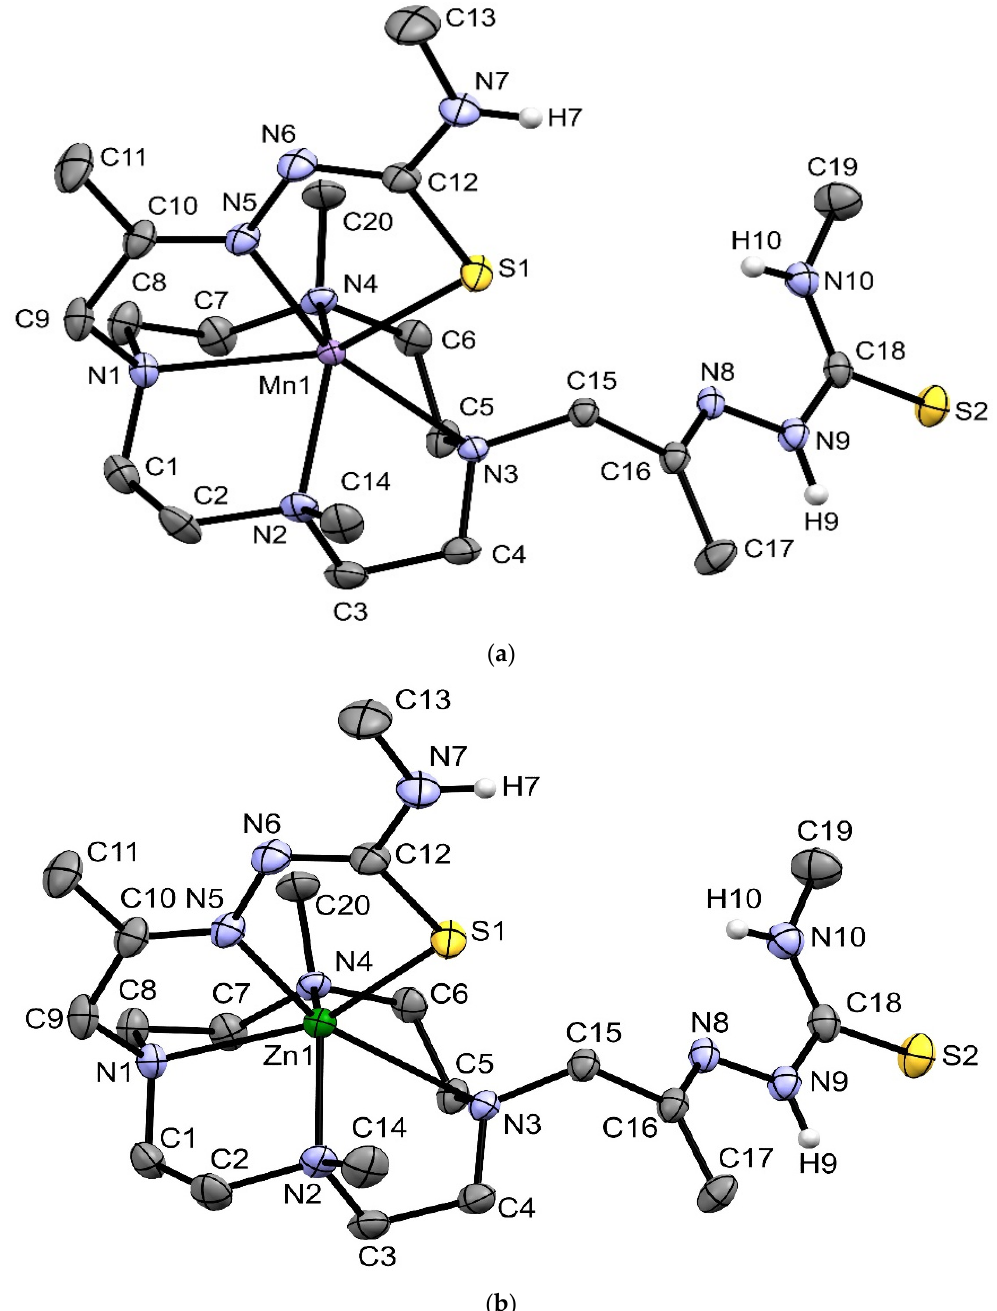
Figure 2. Single-crystal X-ray diffraction structure representations of the ( a ) [Mn1H L ] + and ( b ) [Zn1H L ] + complex cations at 30% thermal ellipsoid probability. Hydrogen atoms are omitted for clarity (except hydrogen atoms bound to nitro- gen).